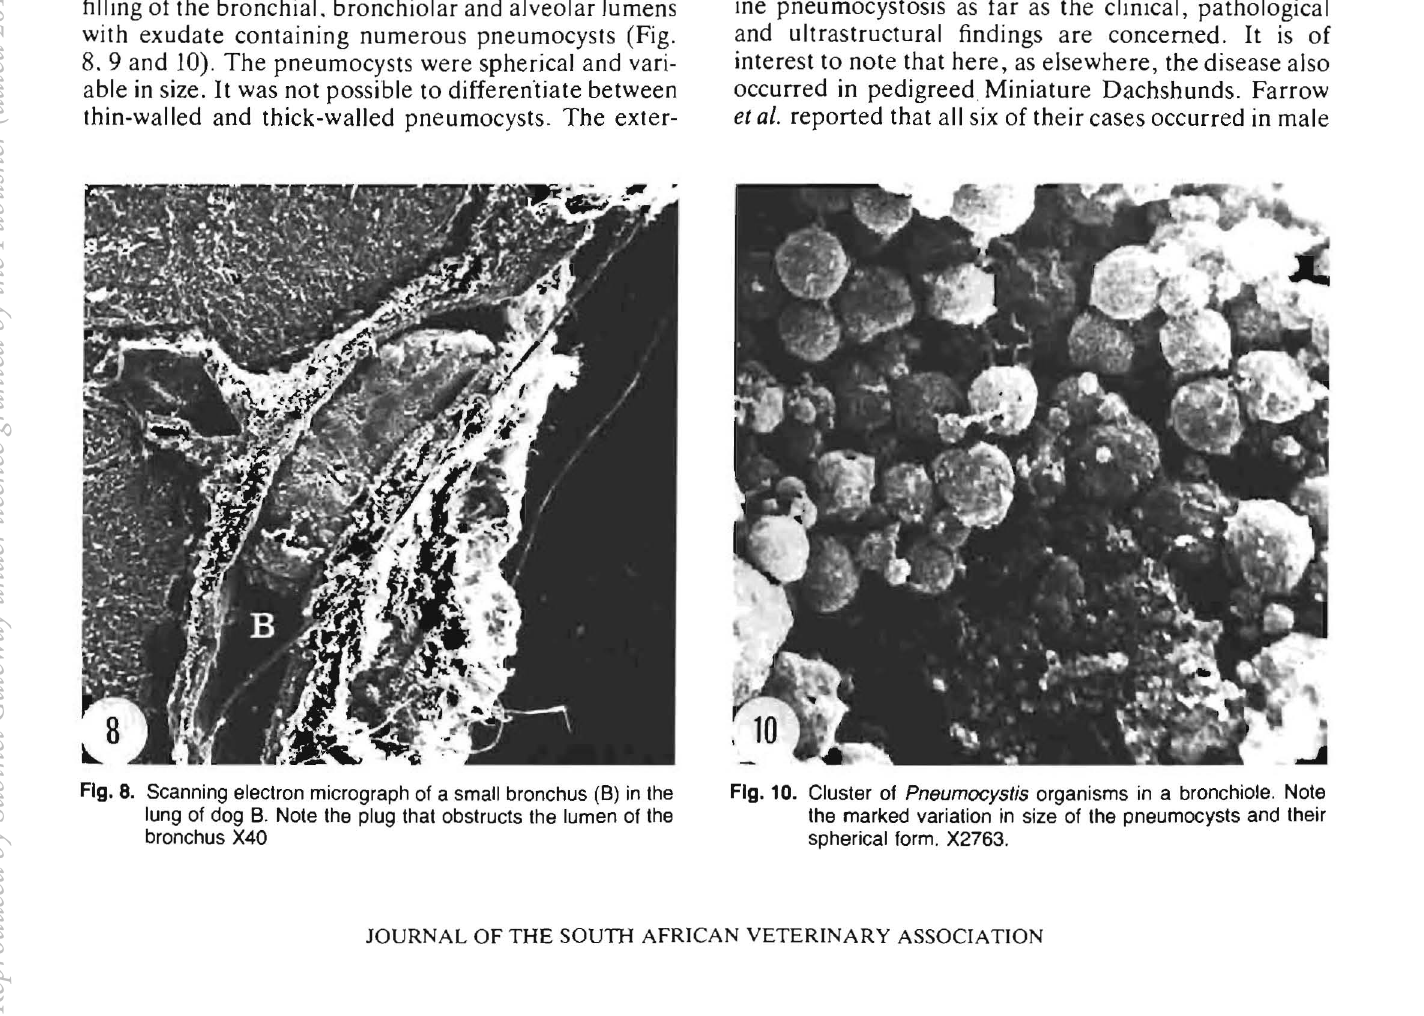
Fig. 10. Cluster of Pneumocystis organisms in a bronchiole. Note the marked variation in size of the pneumocysts and their spherical form.